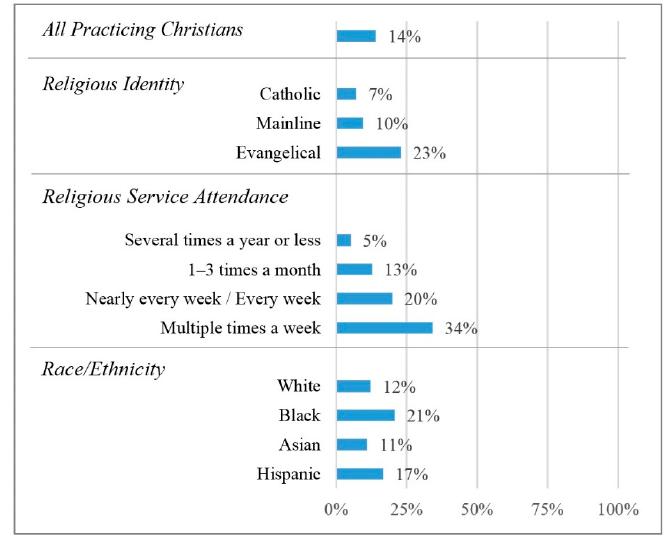
Figure 5. % of people who say their faith leader teaches about the meaning of work often or very often (overall and by subgroup).